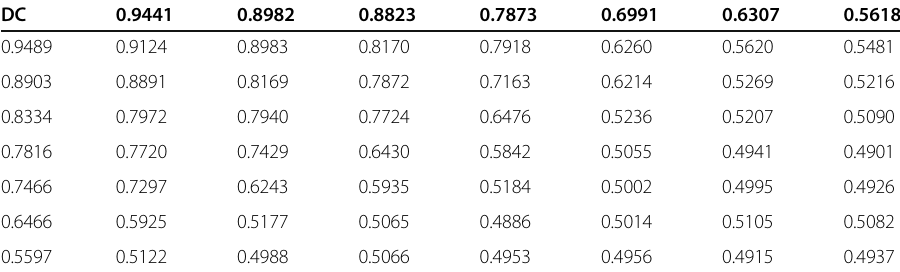
Table 3 Location accuracy for co-frequency sub-images with the optimal merged Markov model DC